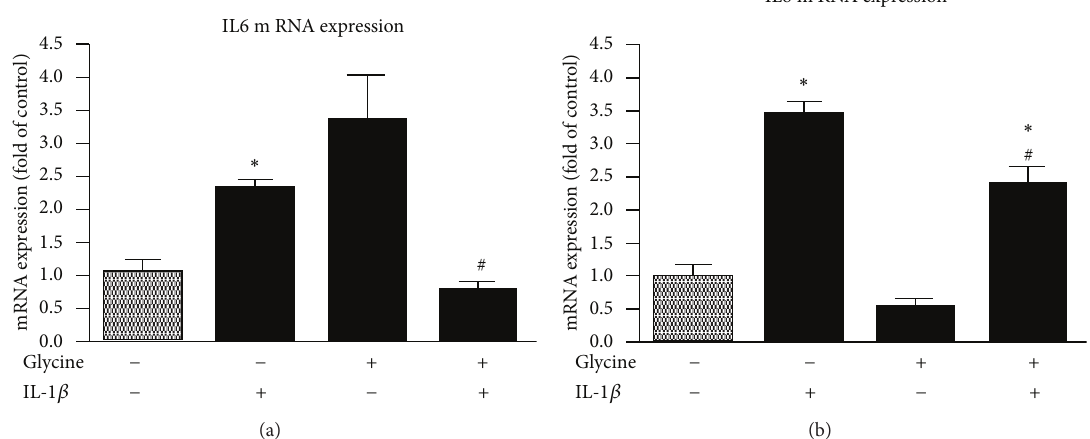
Figure 3: Effect of IL-1 𝛽 and glycine treatment on the mRNA expression of the proinflammatory cytokines IL6 (a) and IL8 (b). Confluent cultures of gingival keratinocytes were treated with IL-1 𝛽 either alone or in combination with glycine to induce inflammatory conditions in vitro . Glycine administration to inflammatory challenged gingival keratinocytes resulted in a decreased proinflammatory cytokine mRNA expression of both IL6 (a) and IL8 (b). Results are presented as means ± SD ( 𝑛 = 10 ); ∗ 𝑃 < 0.05 difference between groups following ANOVA